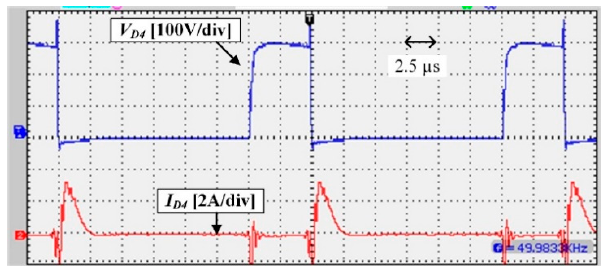
Figure 13. Voltage and current waveform of the switch Q.